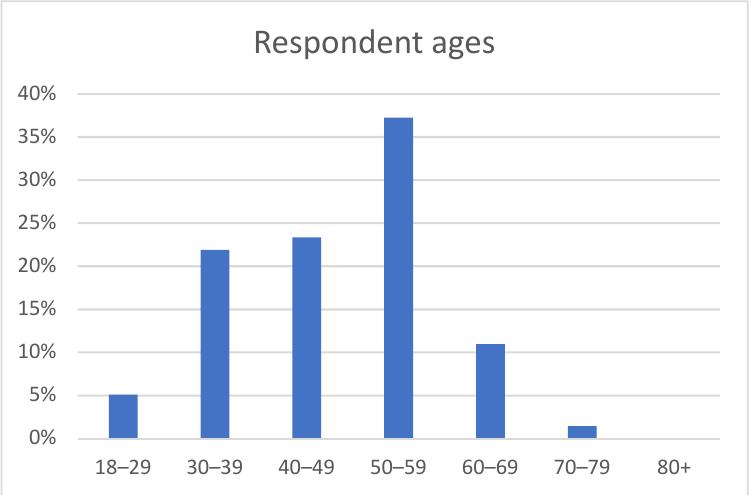
Figure 1. Respondent age ranges.